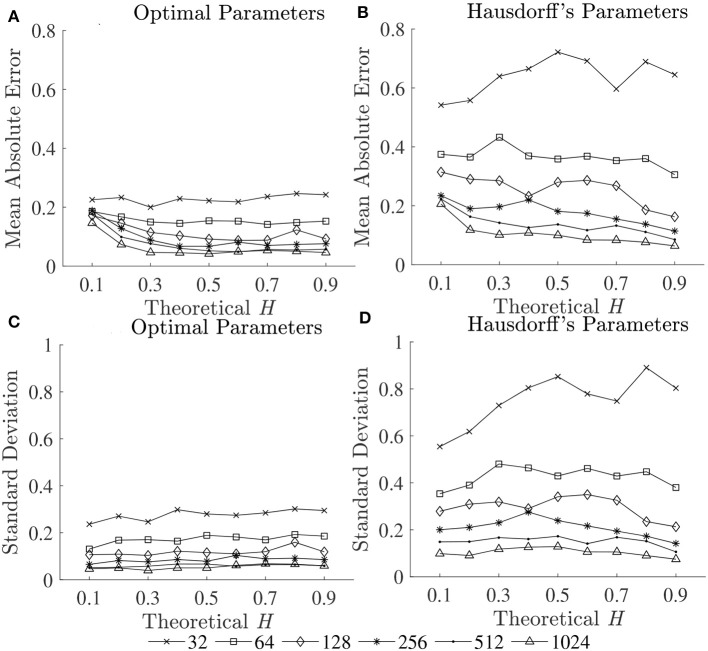
Mean errors (upper panels) and standard deviations (lower panels) of estimated Ĥ using (A,C) optimal parameters and (B,D) Hausdorff's parameters.